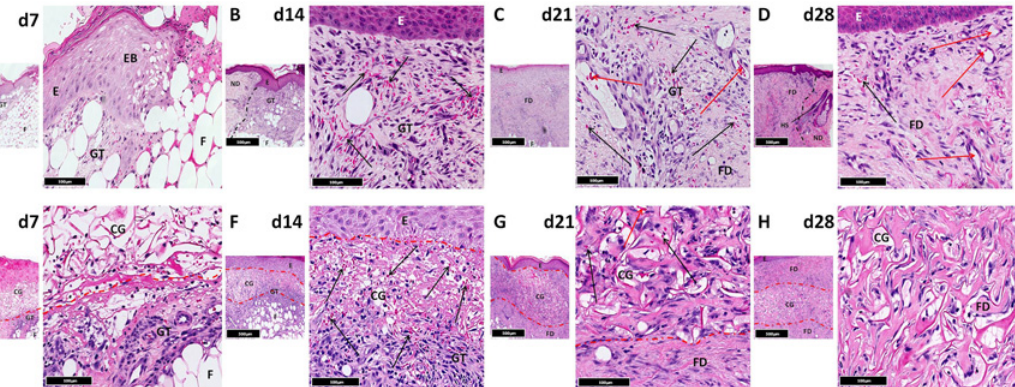
Figure 4. Histological evaluation. Characteristic histological changes in acute cutaneous wounds left to heal by secondary intention (control) (2A-D) and treated with collagen-GAG scaffold (CG) (2E-H) focussing on blood vessel distribution and organisation. In both cases there is rapid development of granulation tissue with subsequent fibrosis, however CG samples develop fewer large vessels than controls. CG — collagen-GAG scaffold, E — epidermis, EB — epidermal bulge, F — subcutaneous fat, FD — fibrotic dermis, GT — granulation tissue, HS — hair shaft, ND — native dermis. Red arrow — patent vessel lumen, Black arrow — granulation tissue vessels. Black dotted line — demarcates border between normal tissue and healing tissue. Red dotted line — demarcates CG. Smaller image — x5 magnification, larger image — x20 magnification.